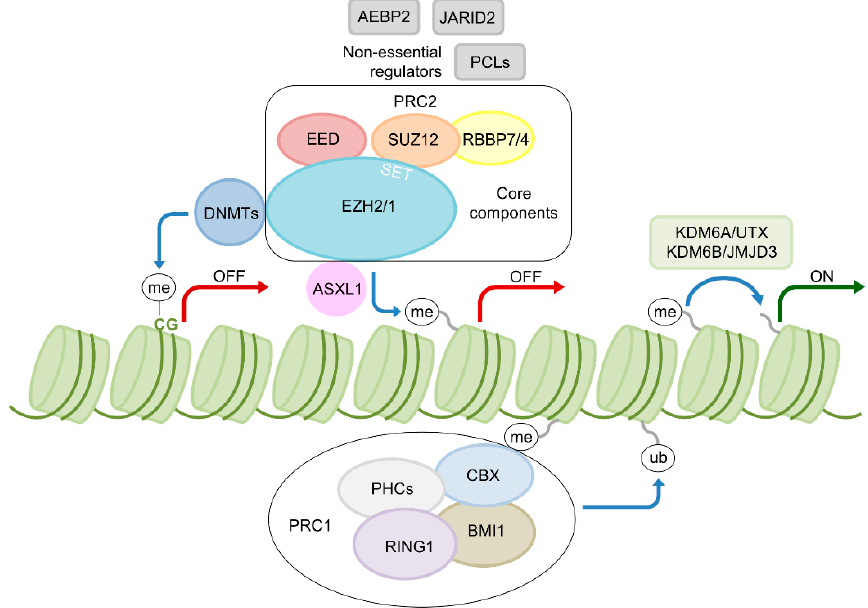
Figure 1. PRC2 and its function in transcriptional regulation. The PRC2 facilitates gene silencing through methylation of H3 lysine 27 and is composed of the core components Enhancer of Zeste Homolog 2 (EZH2), Embryonic Ectoderm Development (EED), Suppressor of Zeste 12 (SUZ12) and Retinoblastoma-binding Protein (RBBP7/4). Other non-essential regulatory proteins, thought to have modulatory and enhancing effects on PRC2 function, include Adipocyte Enhancer-binding Protein 2 (AEBP2), Polycomb-like Proteins (PCLs) and Jumonji and AT-rich Interaction Domain Containing 2 (JARID2) [4,6]. The polycomb complex PRC1, ubiquitinates H2A lysine 119 (H2AK119) and can act downstream of PRC2 to induce gene repression, by binding of trimethylated H3 lysine 27 (H3K27me3) via its Chromobox (CBX) component. Other components include Polycomb Group RING Finger Protein 4 (BMI1), Ring Finger Protein 1 (RING1) and Polyhomeotic Homolog 1 (PHC1) [5]. EZH2 physically interacts with Additional Sex Combs Like 1 (ASXL1) for PRC2 recruitment to target genes [10] and DNA Methyltransferases (DNMTs) to regulate DNA methylation [11]. Demethylation of H3K27 is facilitated through Lysine Demethylase 6A (KDM6A/UTX) and Lysine Demethylase 6B (KDM6B/JMJD3) [12]. me: methylation; ub: ubiquitination; ON/OFF: transcriptional activation/repression of target genes such as Homeobox ( HOX ) genes.